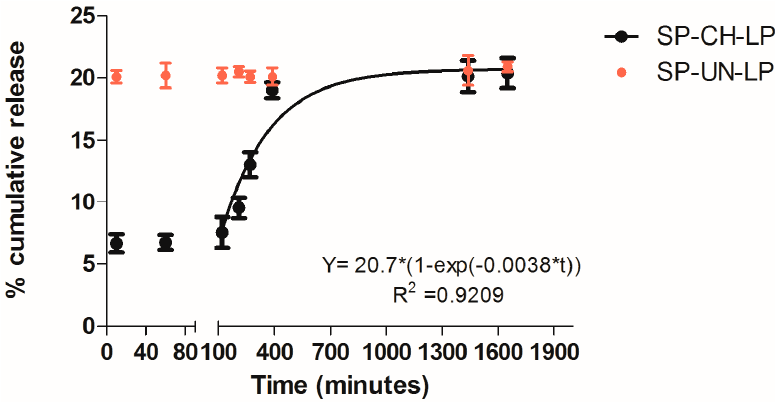
Figure 3. In vitro release of substance P from chitosan-coated and uncoated liposomes (as indicated in legend) in PBS (pH 7.4; 37 °C; n = 3). legend) in PBS (pH 7.4; 37 ◦ C; n =